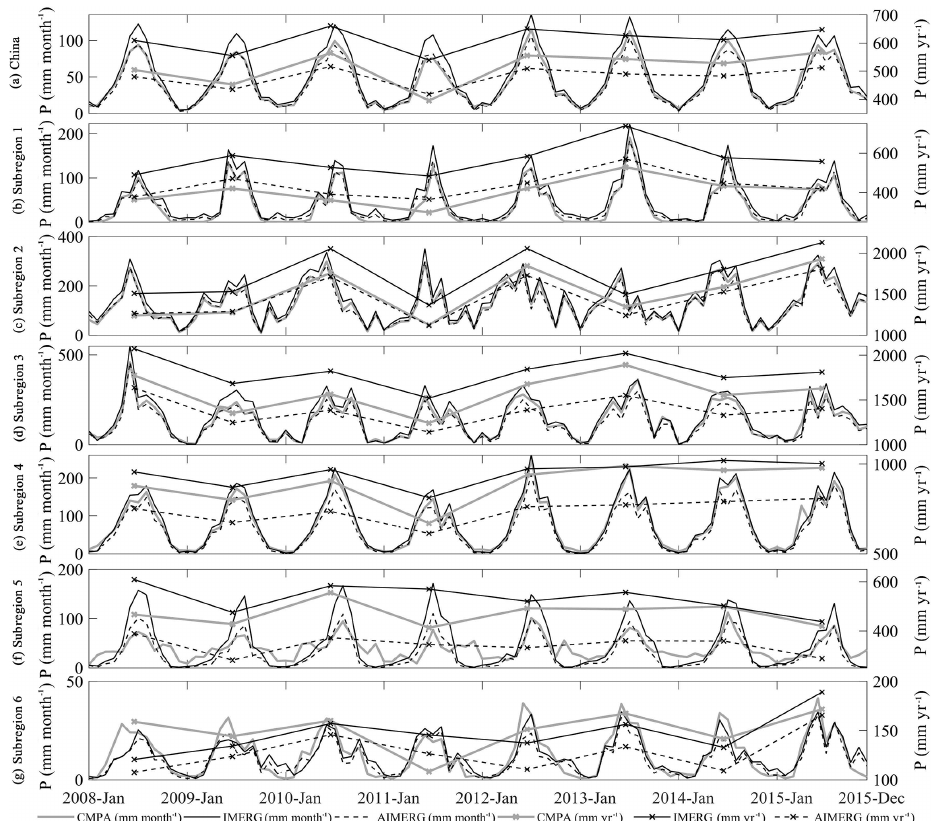
Figure 5. The temporal patterns of mean areal precipitation of IMERG, CMPA, and AIMERG over mainland China and subregions from 2008 to 2015, at monthly and annual